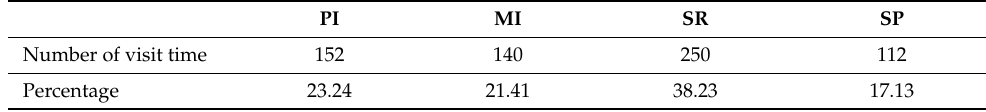
Table 10. Percentage of time that types of attractions and destinations are visited .